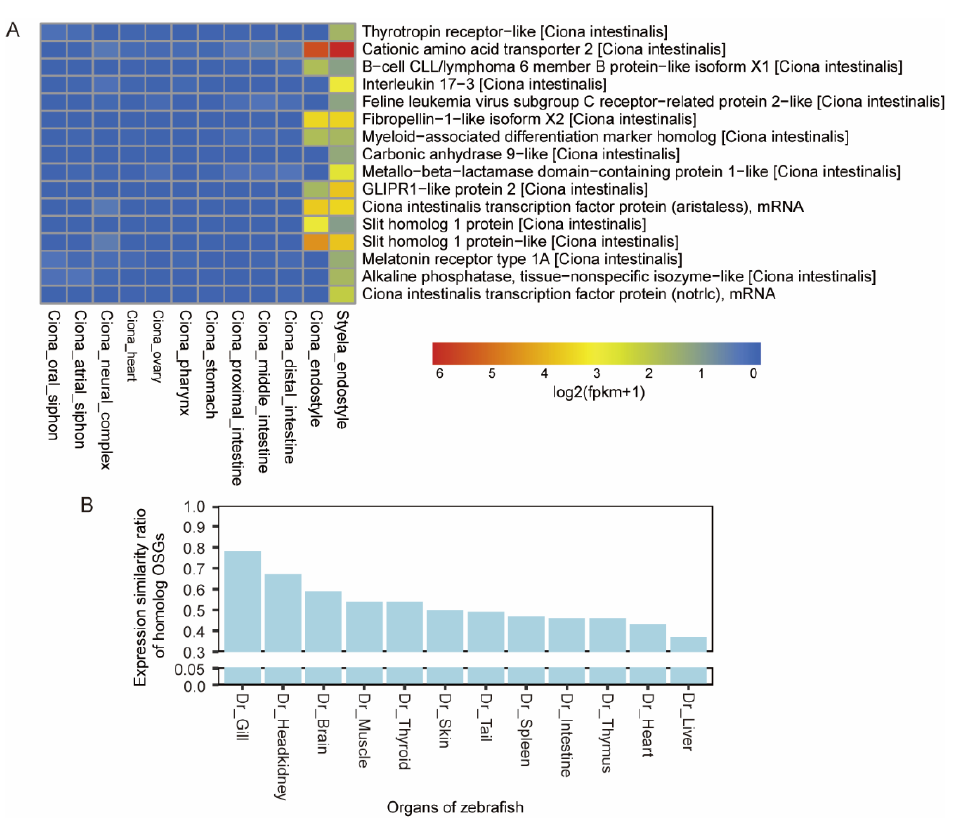
Figure 3. OSG-based expression similarity analysis. ( A ) Identification of OSGs in the endostyle of S. clava , based on the comparison with C. robusta organ or tissue RNA-seq results (except Ciona endostyle). Homolog gene pairs of Ciona and Styela with expression values less than 0.5 in the Ciona organs while expression values larger than 1 in Styela endostyle were defined as OSGs in the endostyle of S. clava ; ( B ) expression similarity ratio calculation based on expression ratio of endostyle OSG homolog in D. rerio organs. The ratio was defined as the percentage of expressed endostyle OSG homolog (TPM larger than 1) in the expression profile of a Danio organ. For instance, for the gill in Danio , more than 70 percent of OSG homologs in Danio were expressed in the gill.